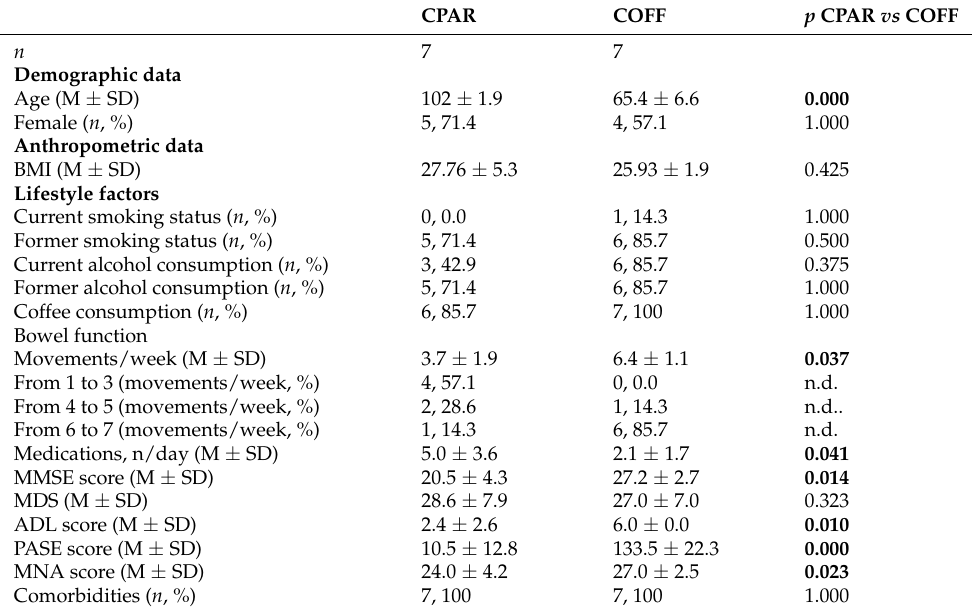
Table 2. Clinical and lifestyle data of CPAR and COFF subjects.